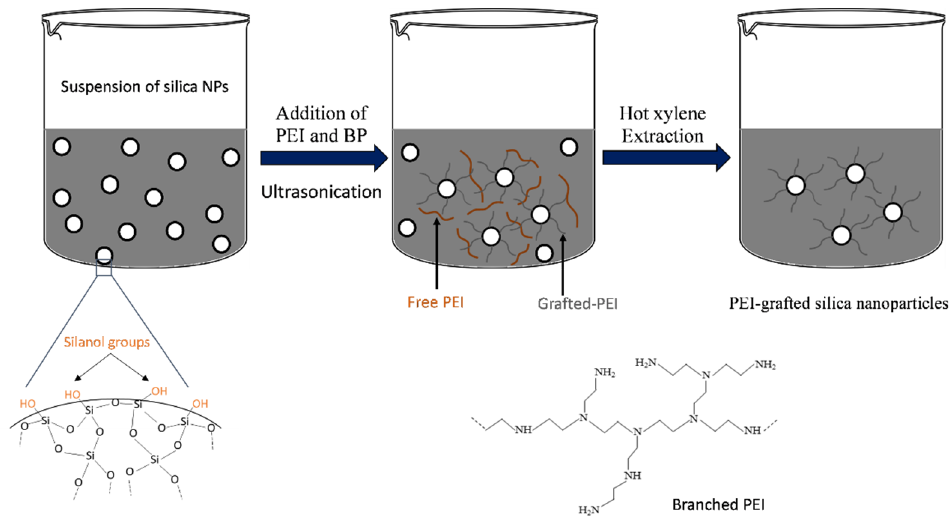
Figure 1. Ultrasonically assisted grafting procedure of the PEI/Si nanocomposites. Table 1. Preparation of PEI/Si nanocomposites labeled PEIX/Y/Z; X, Y and Z refer to PEI’s molecular weight (600–25K), the Si:PEI weight ratio and the BP:Si weight concentration, respectively. BP Conc. [%] BP conc. [%] →